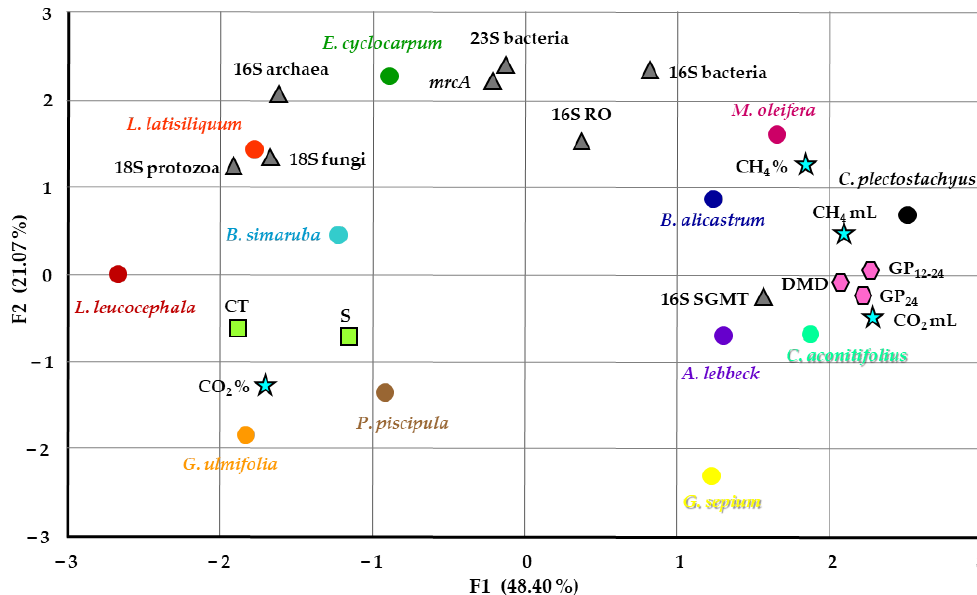
Figure 3. Principal Component Analysis (PCA) of foliage from twelve plants and their relationship with methane and carbon dioxide production, fermentation variables, content of secondary metabolites and microbial populations. PCA analysis spatially resolved differences between the foliage where two factors account for 69% of the differences between all variables. Circles denote the foliage in their respective colors code of Figure 1, blue stars show CH 4 and CO 2 , pink hexagons indicate fermentation variables, lime green squares represent secondary metabolites and grey triangles designate the corresponding microbial populations. CH 4 % and CO 2 %: percentage of CH 4 or CO 2 in GP 12–24 ; CH 4 mL and CO 2 mL: CH 4 or CO 2 in GP 12–24 . DMD: dry matter degradability at 24 h (mg/g DM); GP 12–24 : gas produced between 12 and 24 h of fermentation (mL/g DM); GP 24 : accumulated gas production at 24 h (mL/g DM); CT: condensed tannins (%); S: saponins (%); 16S bacteria, 23S bacteria, 16S archaea, mcrA ( methyl co-enzyme M reductase alpha subunit ), 16S SGMT ( M. smithii , M. gottschalkii , M. millerae and M. thaueri ), 16S RO ( M. ruminantium and M. olleyae ), 18S fungi, 18S protozoa: copies/ µ